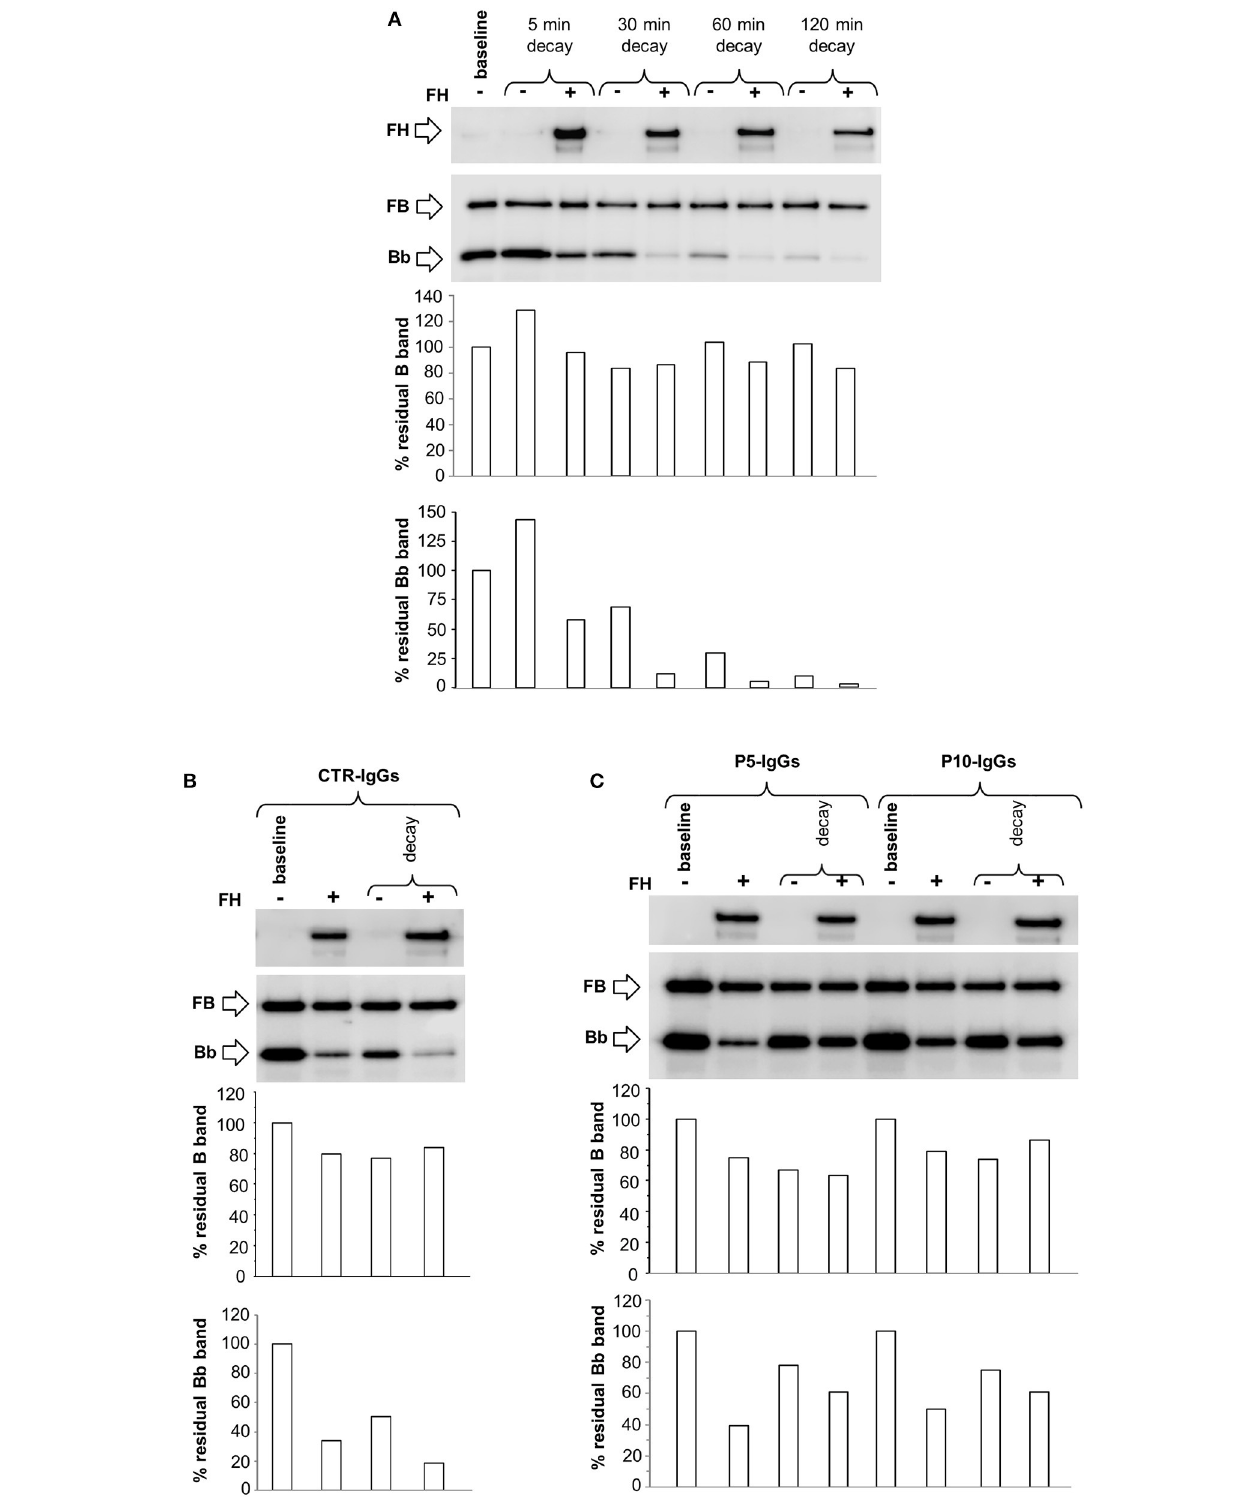
FIGURE 10 | Formation and decay of C3bB(Ni 2 + ) C3 proconvertase and C3bBb(Ni 2 + ) C3 convertase in the absence or in the presence of patient IgGs, by microplate/WB assay. (A) The time course of spontaneous and FH-mediated decay of C3bB(Ni 2 + ) and C3bBb(Ni 2 + ), both formed during 30min at 37 ◦ C (baseline) by incubation of C3b coated wells with FB (1,000ng/ml), FD (10ng/ml), and NiCl 2 (2mM), was monitored by further incubation at 37 ◦ C for 5, 30, 60, and 120min with